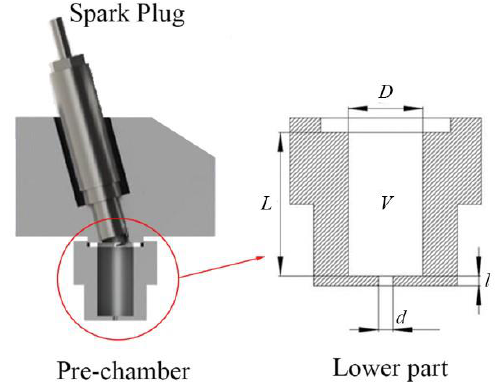
Figure 4. Structure of the pre-chamber.